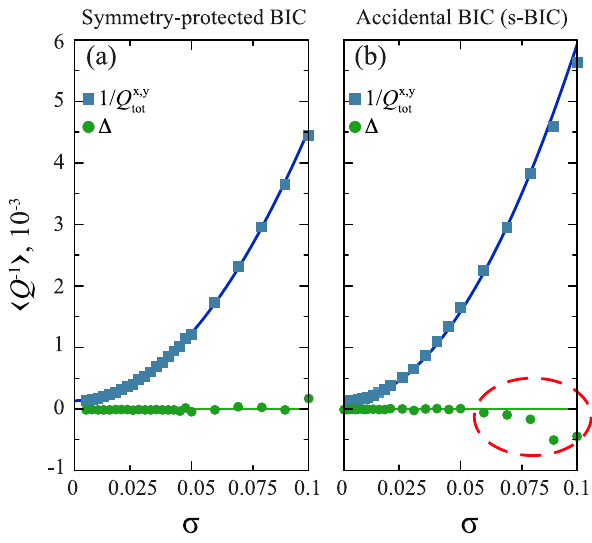
Figure 4: Average Q − 1 of (a) the symmetry-protected BIC, (b) the accidental s-BIC. Blue squares show dependence of inverse average Q factor on the disorder degree along both axes, green points are the difference according to Eq. (4). Solid lines are guides for an eye only. Red dashed circle shows the region of 𝜎 , where Eq. (4) is not